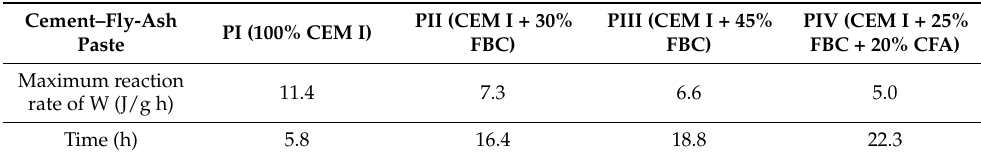
Table 7. The maximum reaction rate of C 3